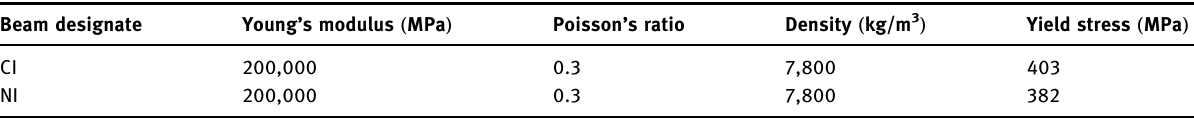
Table 2: Steel reinforcement material properties Beam